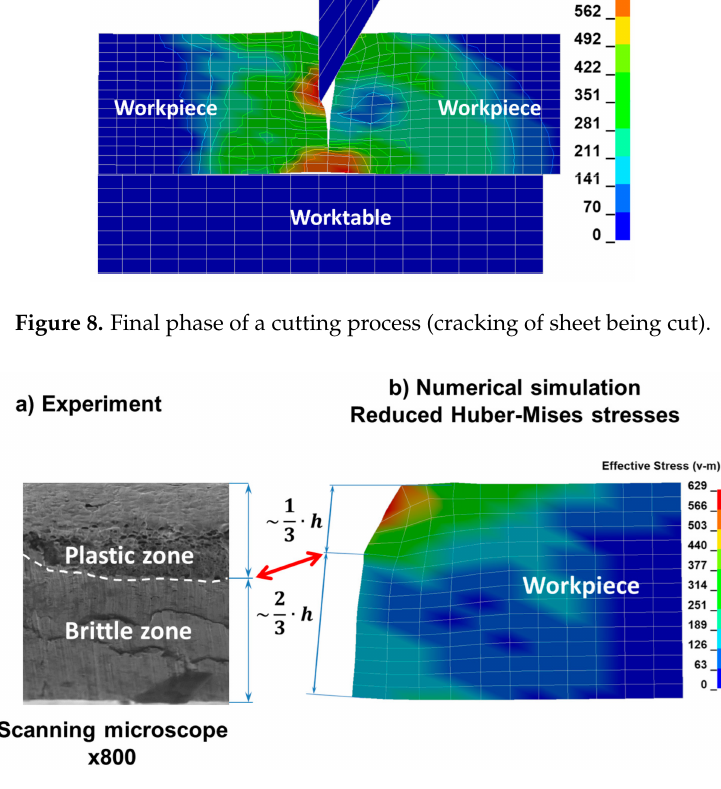
Figure 9. Comparison of the experimental and numerical results: ( a ) view from the forefront of the steel sheet being cut; ( b ) reduced Huber–Mises stresses (the permanent plastic deformation at the left upper edge is